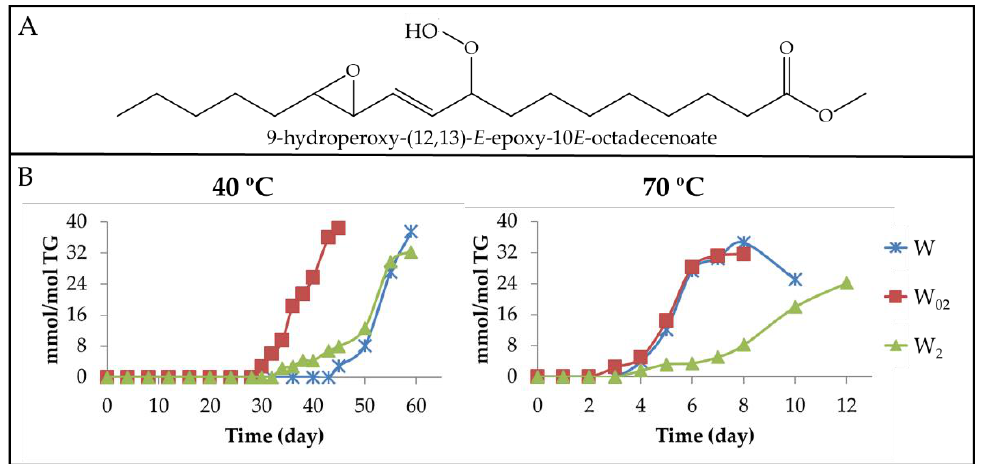
Figure 7. ( A ) Structure of 9-hydroperoxy-(12,13)- E -epoxy-10 E -octadecenoate as an example of non- vicinal mHPO-mEPO- E -mE. ( B ) Evolution of the concentration expressed as mmol/mol TG, of all non-vicinal mHPO-mEPO- E -mEs present in walnut oil samples with different enrichment levels of αT (W, W 02 and W 2 ), submitted to either 40 °C or 70 °C, up to advanced stages of the oxidation process.